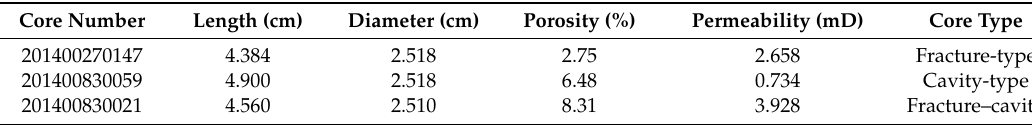
Table 1. Petrophysical properties of cores.